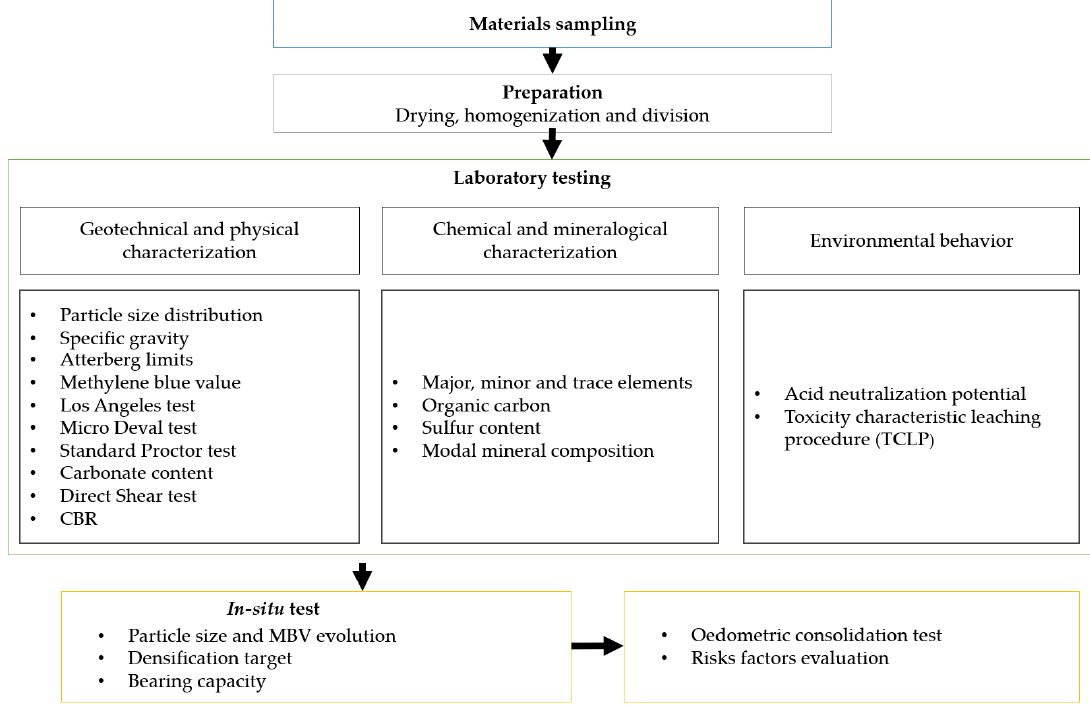
Figure 3. Summary of the followed methodology.